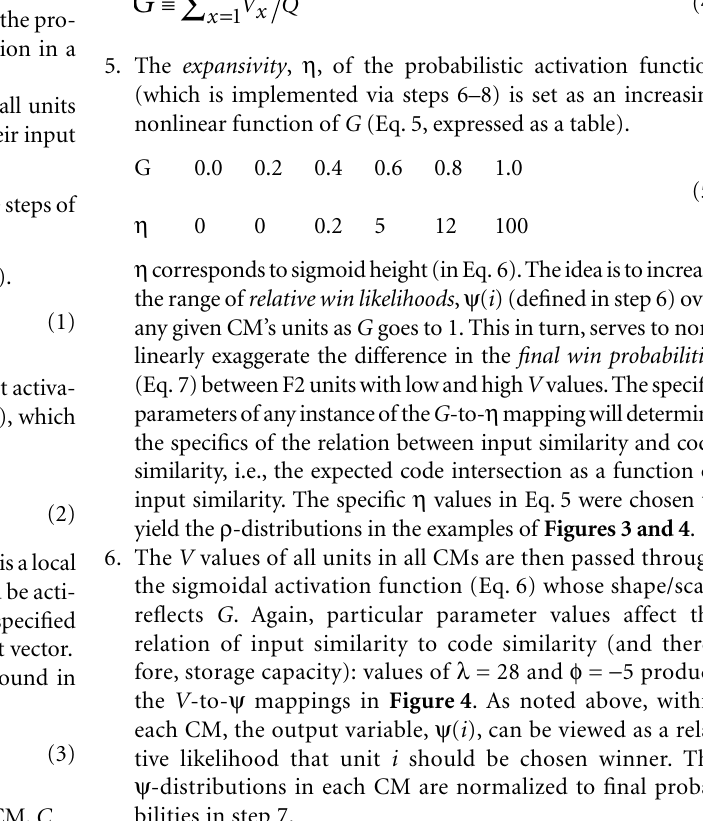
activation function ( Figure 2 : purple arrows) in preparation for the second competitive round, which is a soft WTA competition,